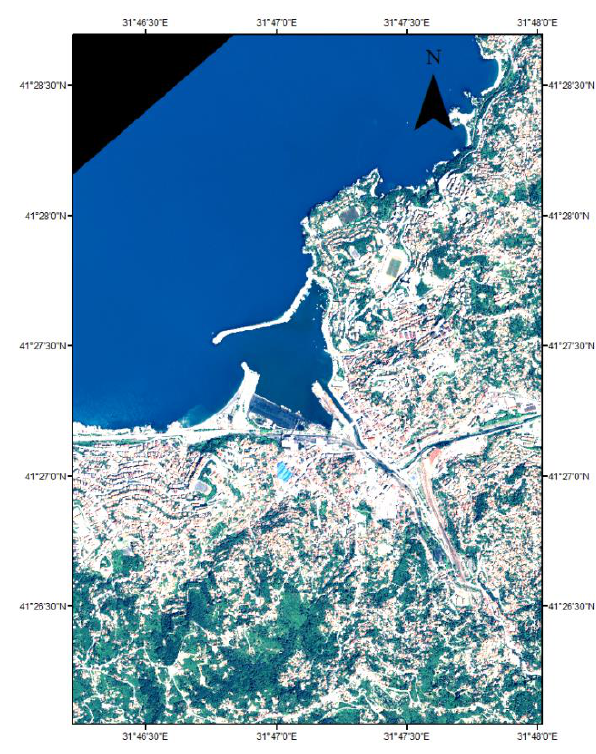
Figure 1. Test site from Zonguldak on Quickbird pan- sharpened VHR satellite imagery